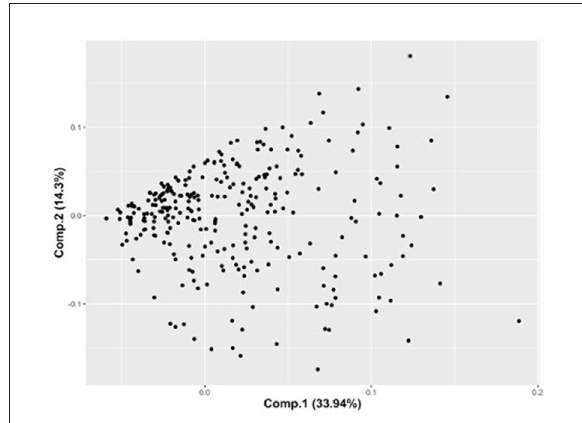
FIGURE1 Score plot of dogs on the first (PC 1) and second (PC 2) principal components, with the increase in temperature.